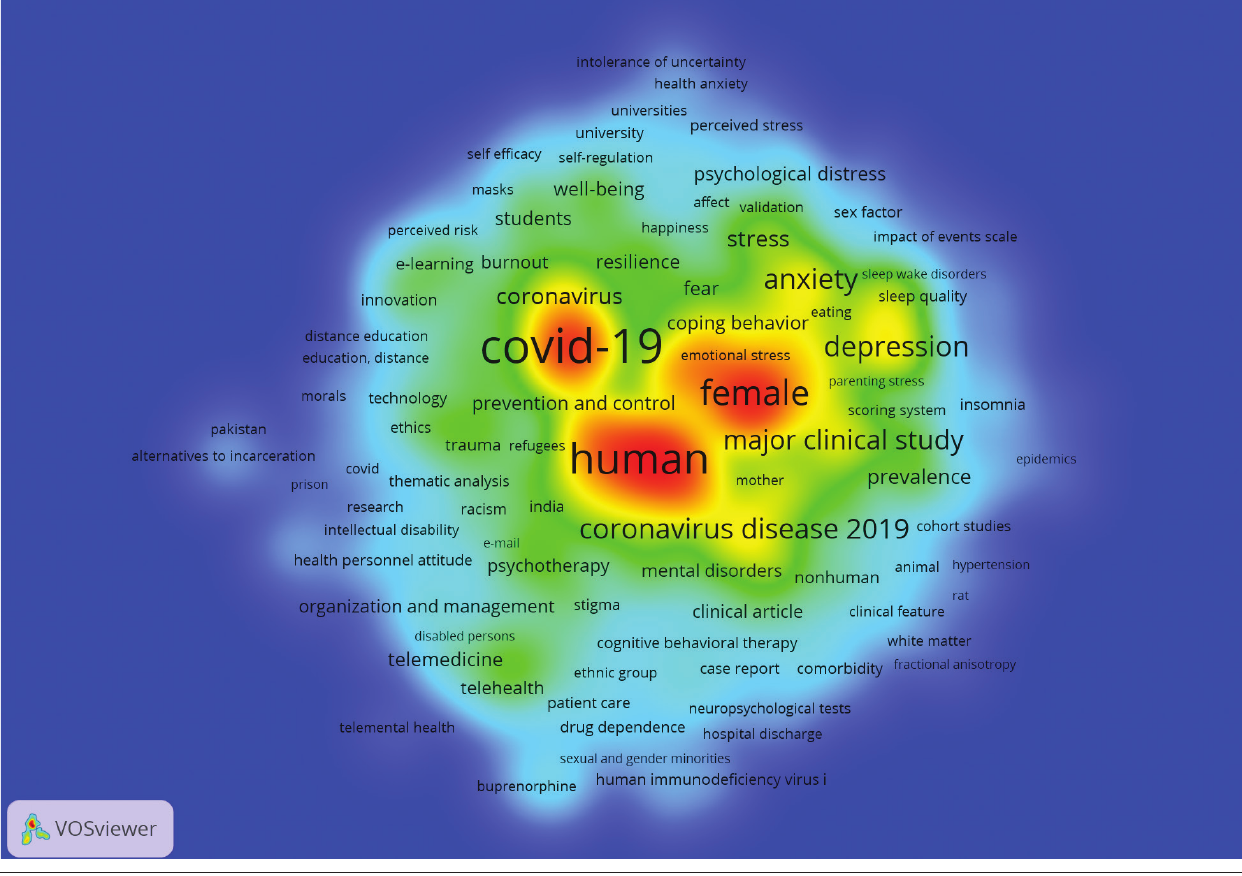
FIGURE 2: The density